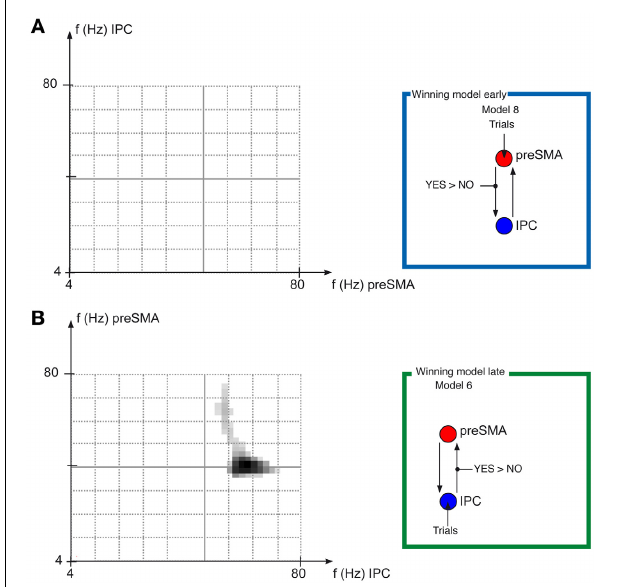
FIGURE 4 | Frequency-Frequency coupling in winning models. Results of the DCM analysis frequency-frequency paired t -tests. (A) Shows the results of the paired t -test of Frequency-pairs for the early task phase, testing whether the coupling from preSMA to IPC is significantly ( p < 0 . 05 FWE cluster level, based on p < 0 . 05 uncorrected tests of individual frequency pairs) different for AgencyYES compared with AgencyNO trials. (B) Shows the results of the paired t -test of Frequency-pairs for the late task phase, testing whether the coupling from IPC to preSMA is significantly ( p < 0 . 05 FWE cluster level, based on p < 0 . 05 uncorrected tests of individual frequency pairs) different for AgencyYES compared with AgencyNO trials, which is the case in the 50–60Hz frequency range for IPC, which then increases the power in the frequencies 40–70Hz increases in preSMA more for AgencyYES compared with